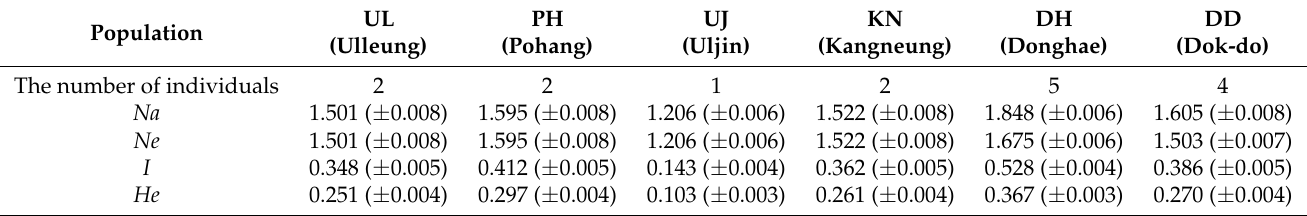
Figure 1. Trapping sites for rats ( Rattus sp.). Dok-do (left above inset). Relative position of study area within the Pacific Ocean (left below inset). Korean Peninsula east coast and Ulleung-do with Dok-do (right inset). See Table 1 for abbreviation definitions. Table 1. Summary of genetic diversity indices for Rattus norvegicus along the east coast with Ulleung and Dok-do islands in South Korea. Na —number of alleles. Ne —number of effective alleles. I —Shannon’s information index. He —expected heterozygosity. The parentheses represent standard